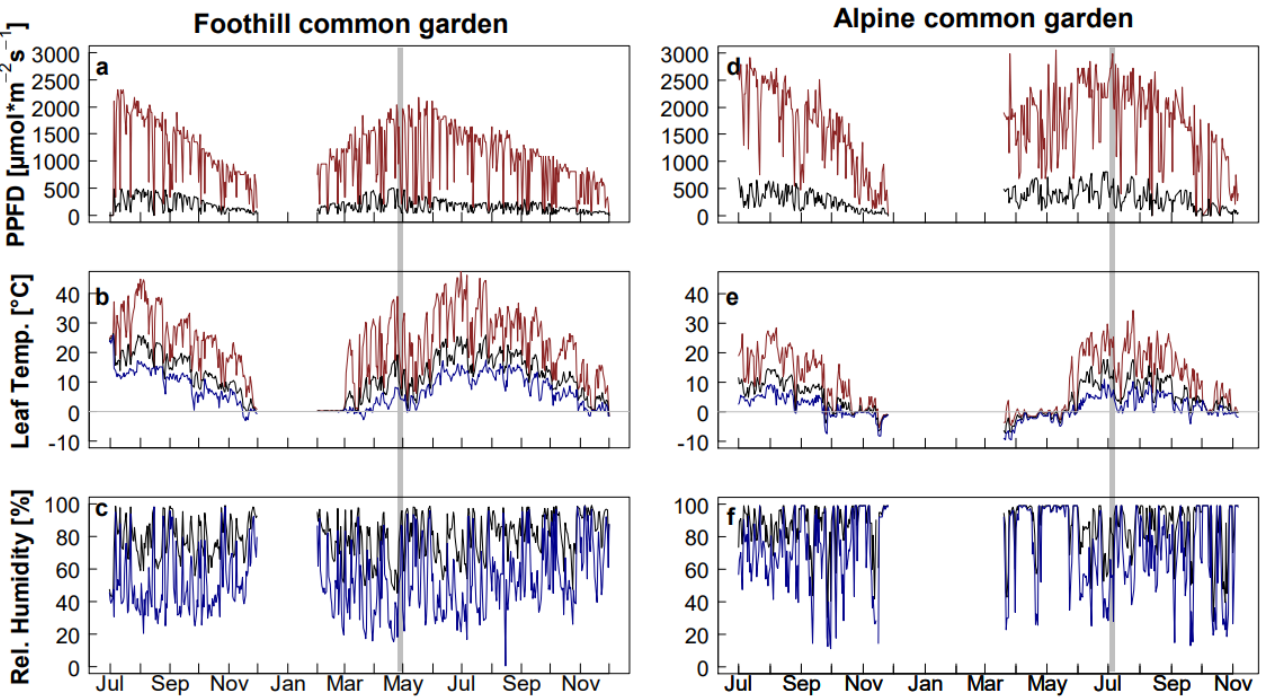
Figure 1. Environmental conditions in the common gardens used for reciprocal transplantation. Data were collected between July 2018 and November 2019, except for time periods with snow coverage, in common gardens set up in the natural habitats of ( a – c ) the foothill and ( d – f ) the alpine ecotype. ( a , d ) Daily maxima (red) and means (black) of photosynthetic photon flux density (PPFD). ( b , e ) Daily maxima (red), means (black) and minima (blue) of leaf temperature, averaged for rosettes of six individual plants each; thin grey horizontal lines in ( b , e ) indicate 0 °C. ( c , f ) Daily means (black) and minima (blue) of relative humidity. Grey bars show the sampling dates at the onset of the growing season in the respective habitat.